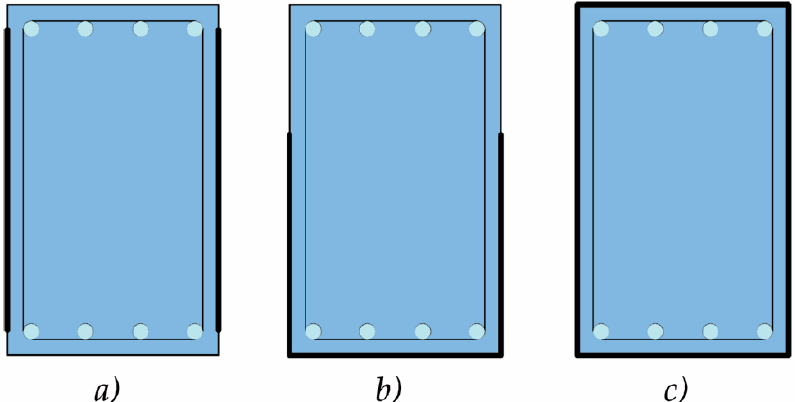
Figure 1. FRP sheets detailing: ( a ) Side-Bonding (S); ( b ) U-shaped (U); and ( c ) Completely-Wrapped (C).